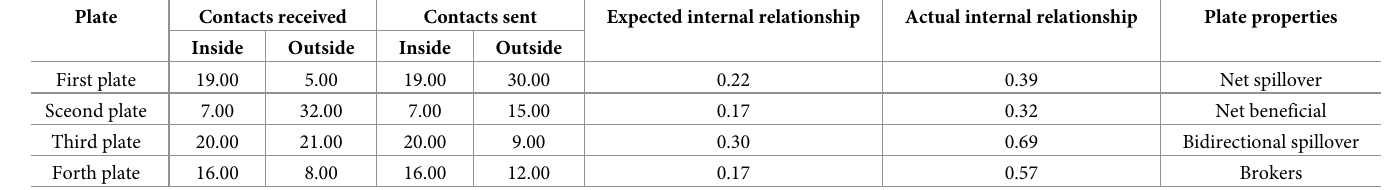
Table 2. Innovation efficiency spillover effects within the Chinese new energy vehicle industry correlation plates in 2019.